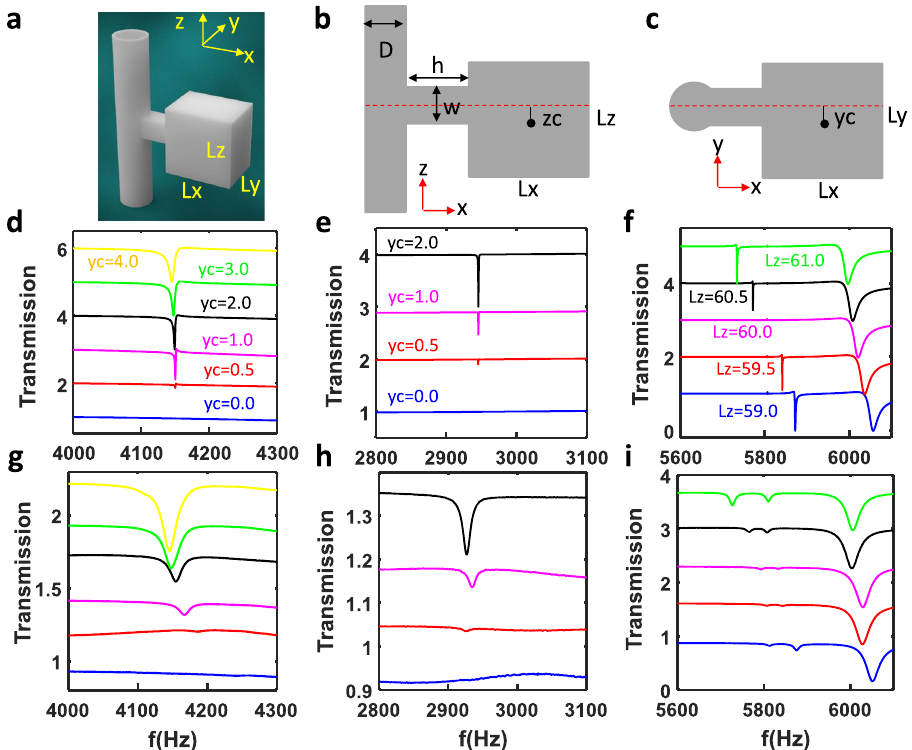
Fig. 4 Transmission spectra of an open resonator. a Schematic drawing of the 3D open resonator. b Cross-section in XoZ plane for the 3D open resonator. c Cross-section in X o Y plane for the 3D open resonator. d – f Simulated transmission spectra for full resonator ( Lx = Ly = Lz = 60 mm) with different y c ( d ), half resonator ( Lx = 30 mm, Ly = Lz = 60 mm) with different y c ( e ) and full resonator ( Lx = Ly = 60 mm) for different values of Lz ( f ). g – i Measured transmission spectra for full resonator ( Lx = Ly = Lz = 60 mm) with different y c ( g ), half resonator ( Lx = 30 mm, Ly = Lz = 60 mm) with different y c ( h ) and full resonator ( Lx = Ly = 60 mm) for different values of Lz ( i